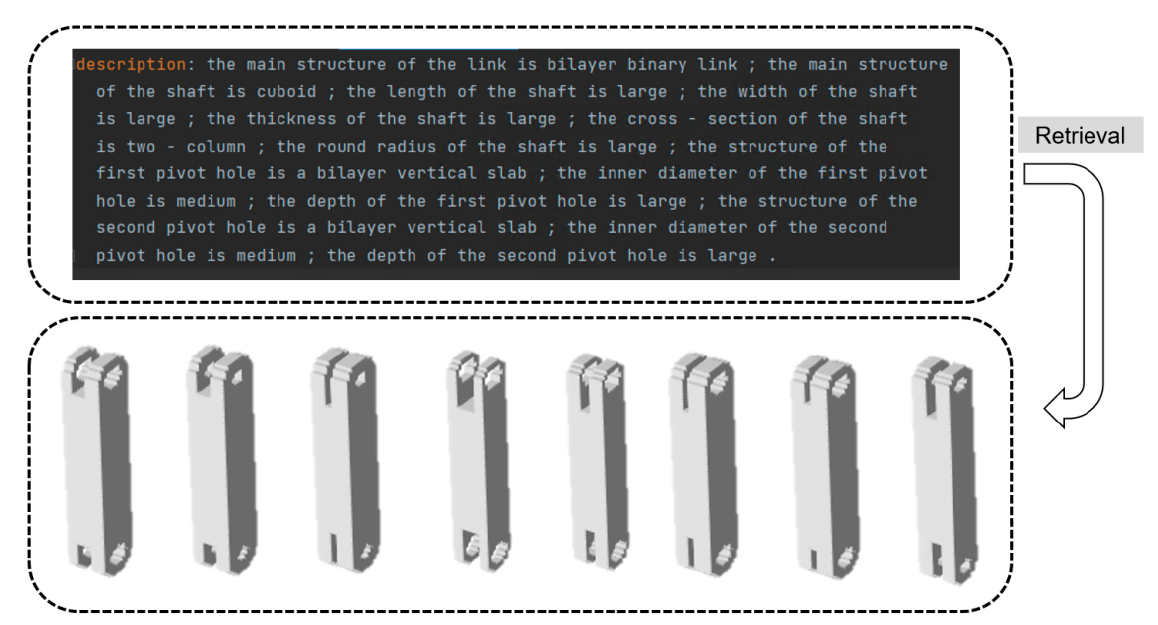
Figure 8. An example of the retrieval experiments.